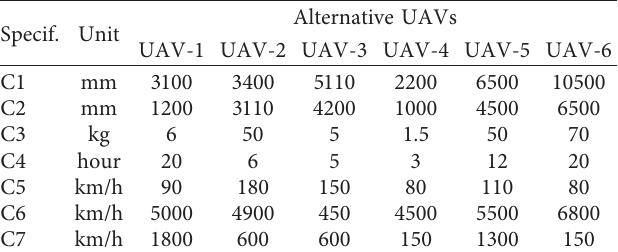
Table 2: UAVs and their specifications. Specif. Unit